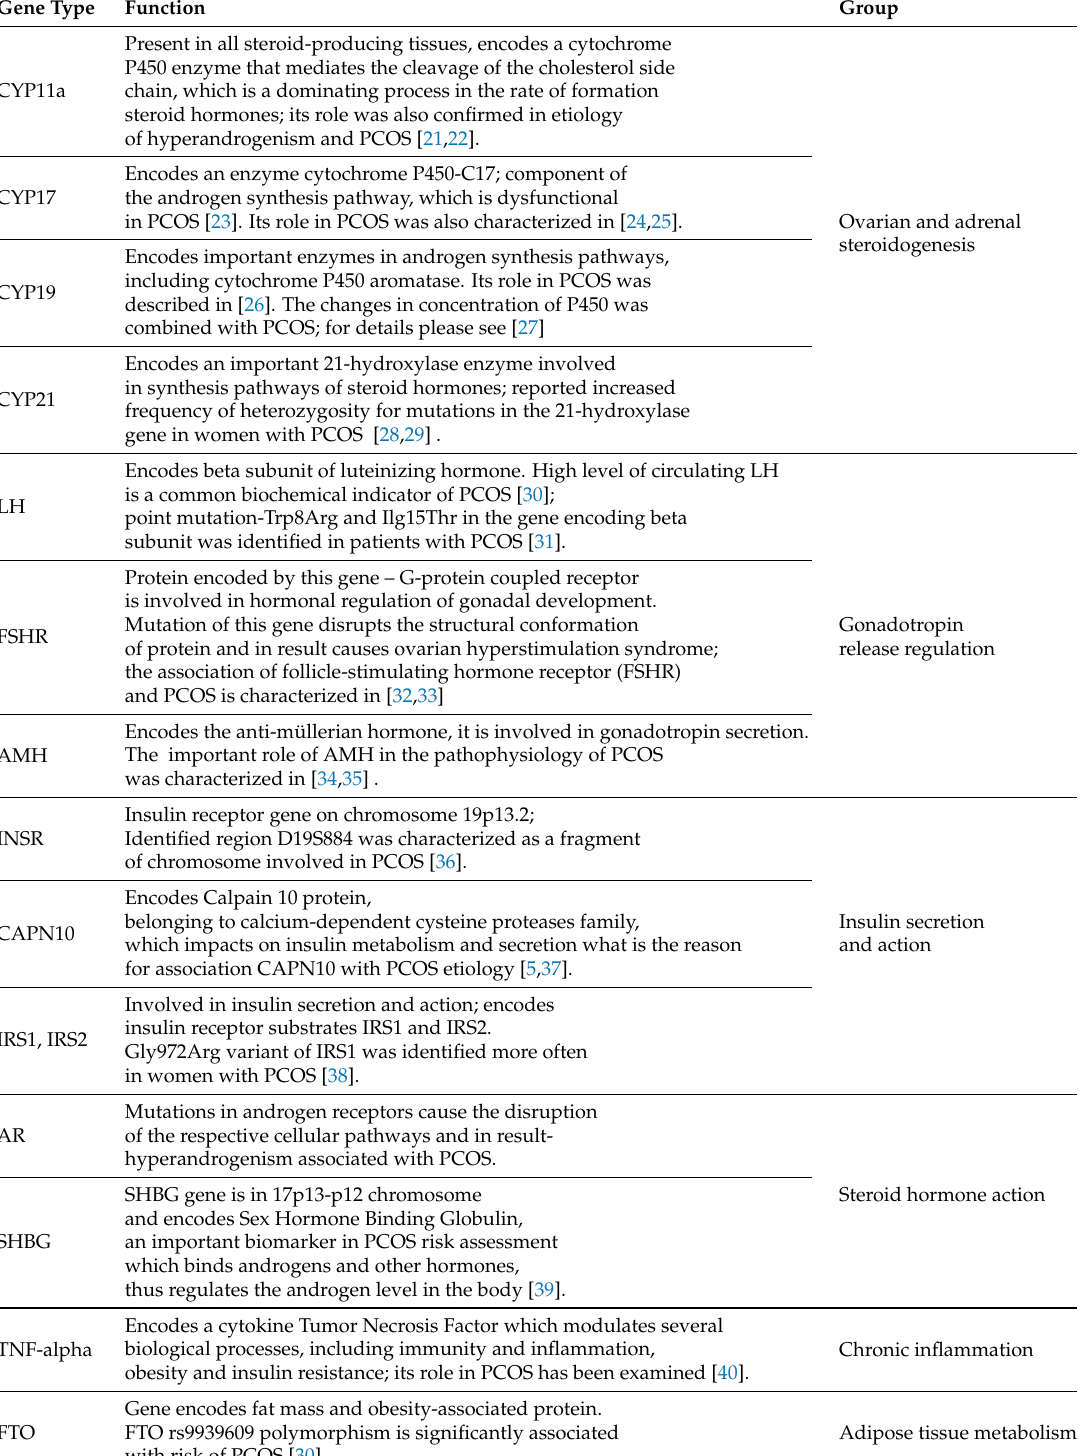
Table 1. Selection of the most important genes involved in PCOS